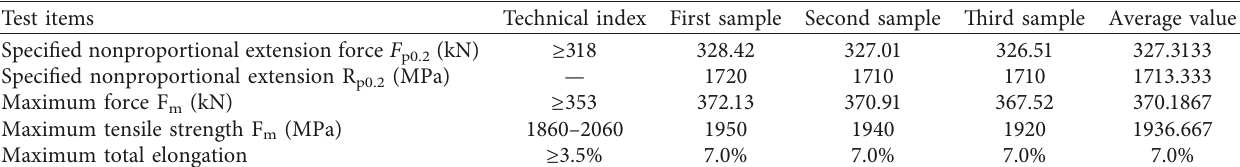
Table 2: Mechanical properties of stranded wire.